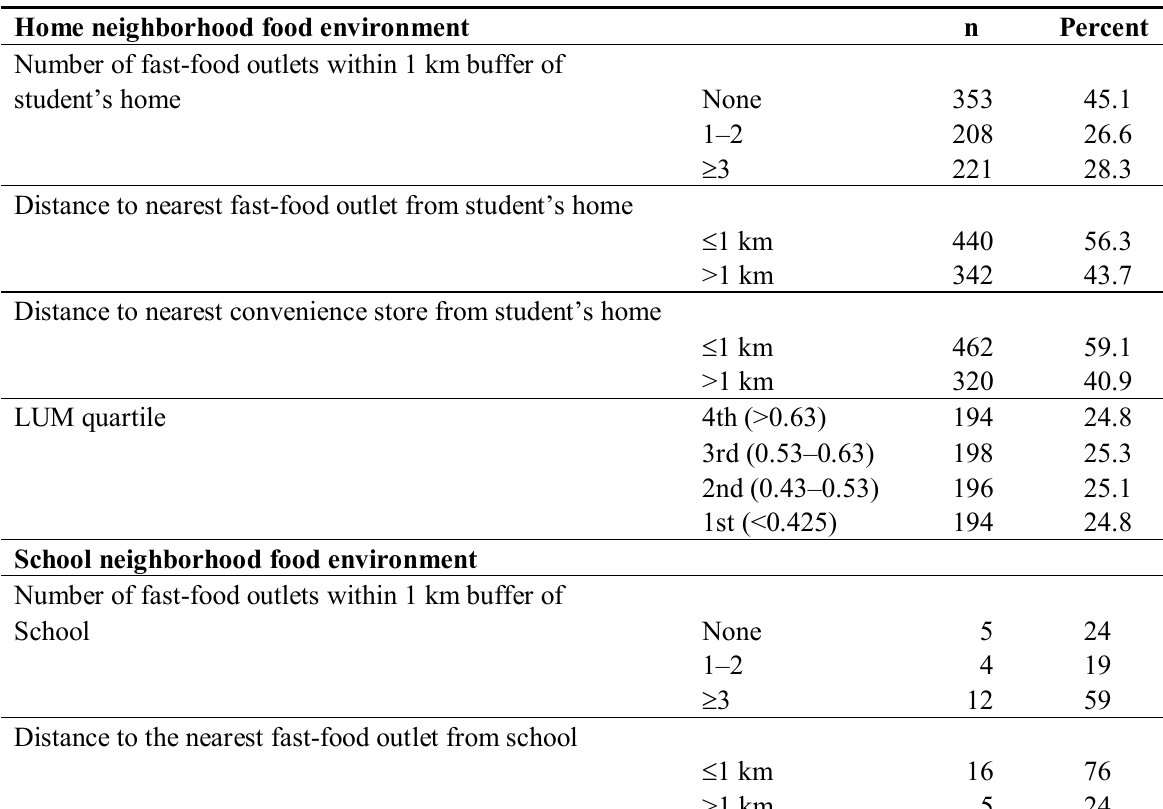
Table 3. Home neighborhood and school neighborhood food environment characteristics (n =